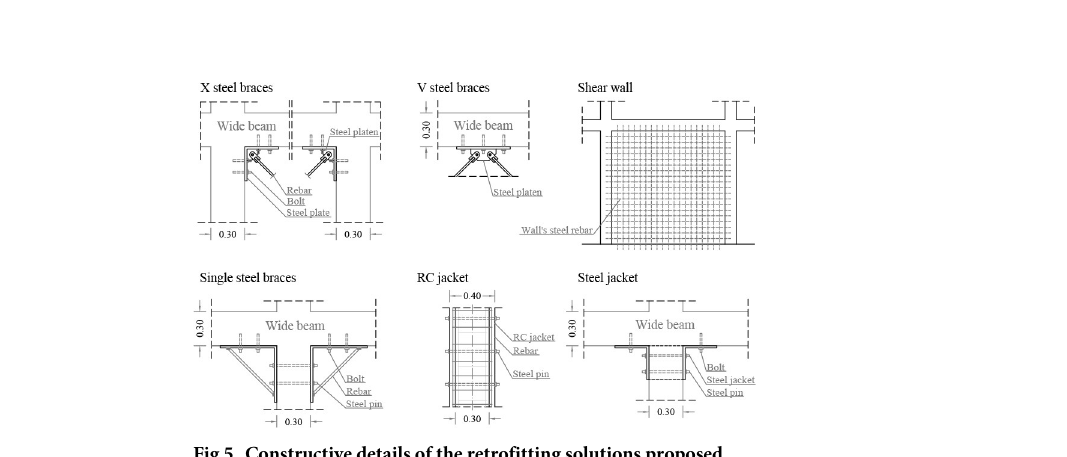
Fig 5. Constructive details of the retrofitting solutions